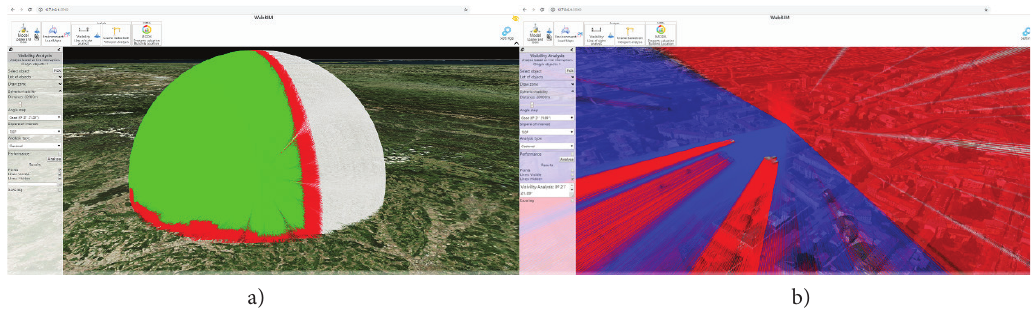
F igure 8. Visualisation of the QUVIAS method: a – view sphere presented by lines; b – part of the view sphere